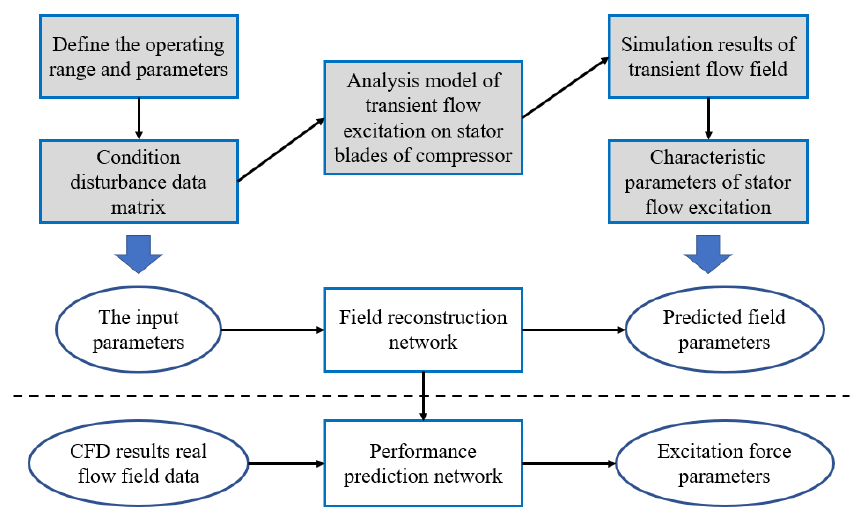
Figure 1. Overall Figure 1. Overall framework.